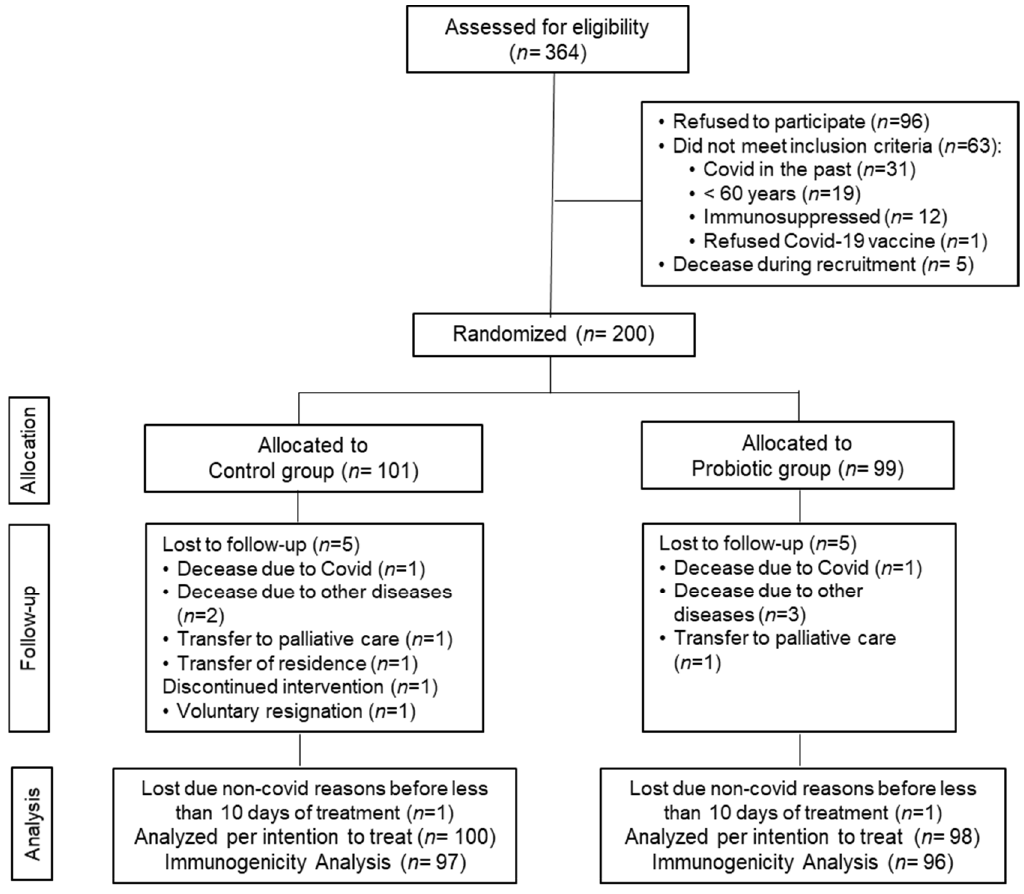
Figure 1. Flow chart of the study. The baseline characteristics of the 198 older adults included in the ITT group are pre- sented in Table 1. No significant differences were detected between the subjects in the study groups except for suffering from cancer in the past (3% of the volunteers in the control group vs. 15.3% in the probiotic group, p = 0.003). Table 1. Baseline characteristics of the subjects participating in the study.